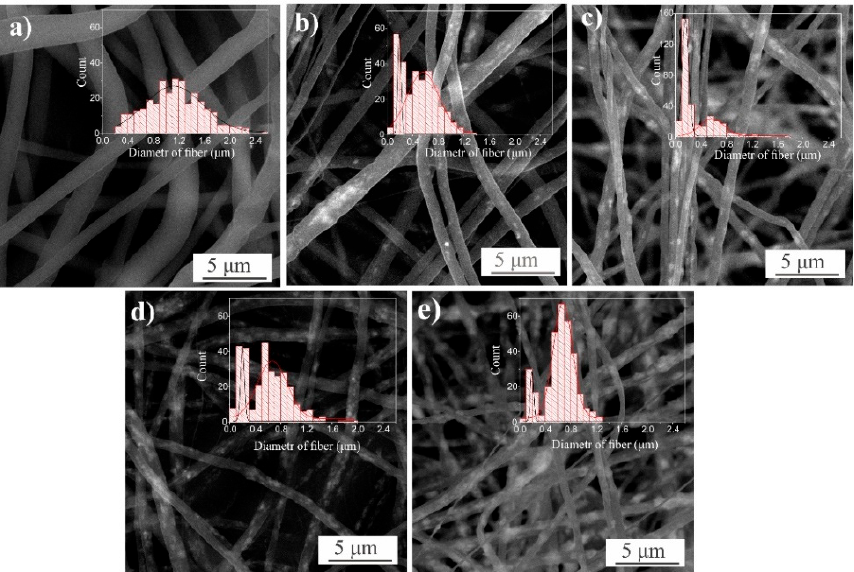
Figure 1. SEM images of PLLA ( a ) and PLLA/ZnO ( b – e ) membranes, with fiber diameters presented as histograms. ZnO NPs are loaded into the samples as: 0 ( a ), 5 ( b ), 10 ( c ), 20 ( d ), and 40 ( e ) wt.%. Table 1. Physical and mechanical characteristics of the as-prepared membranes (average ± standard deviation).